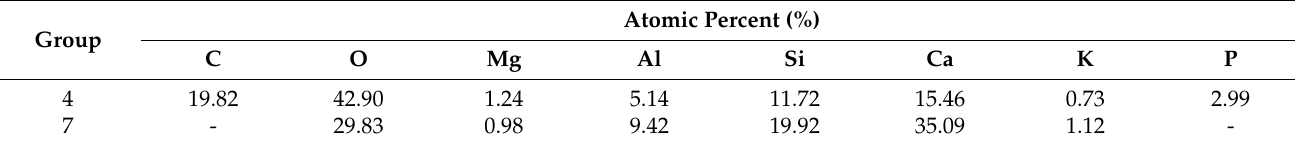
Table 5. The element composition of